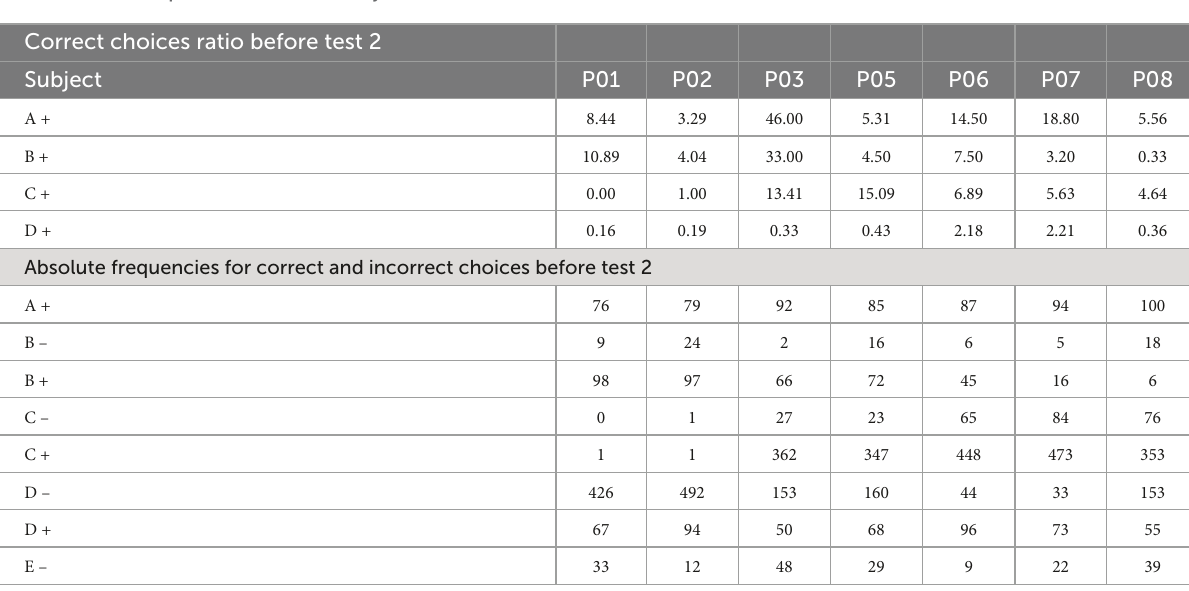
TABLE 3 Correct responses ratio for each subject before test